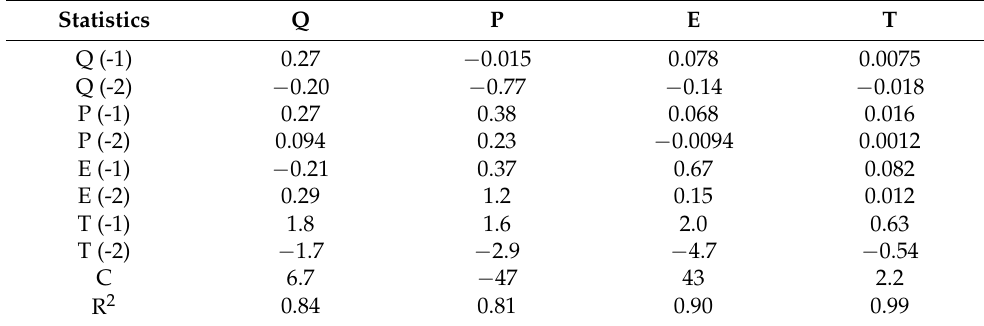
Table 6. Coefficients for the VAR model constructed by hydro-meteorological factors.